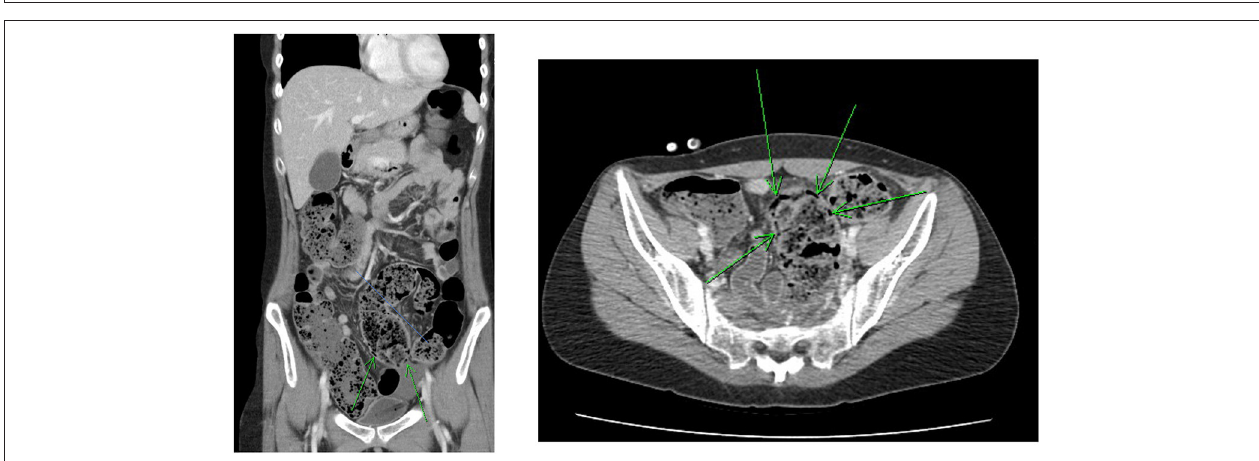
FIGURE 1 | (A) The initial abdominal plain film showed non-specific bowel gas distribution without abnormal calcification or free air. (B) Ultrasonography of the abdomen revealed colon dilatation with air-fluid levels and ascites.